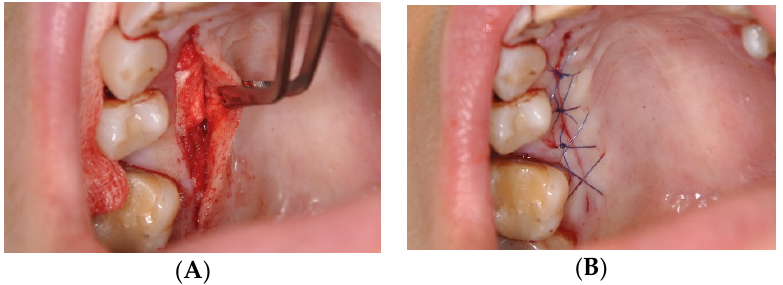
Figure 10. Augmentation of palatal mucous membrane using Biokol ® lyophilized collagen sponge: ( A ) Creation of split thickness flap and insertion of Biokol ® sponge ( B ) Donor site after augmentation procedure.